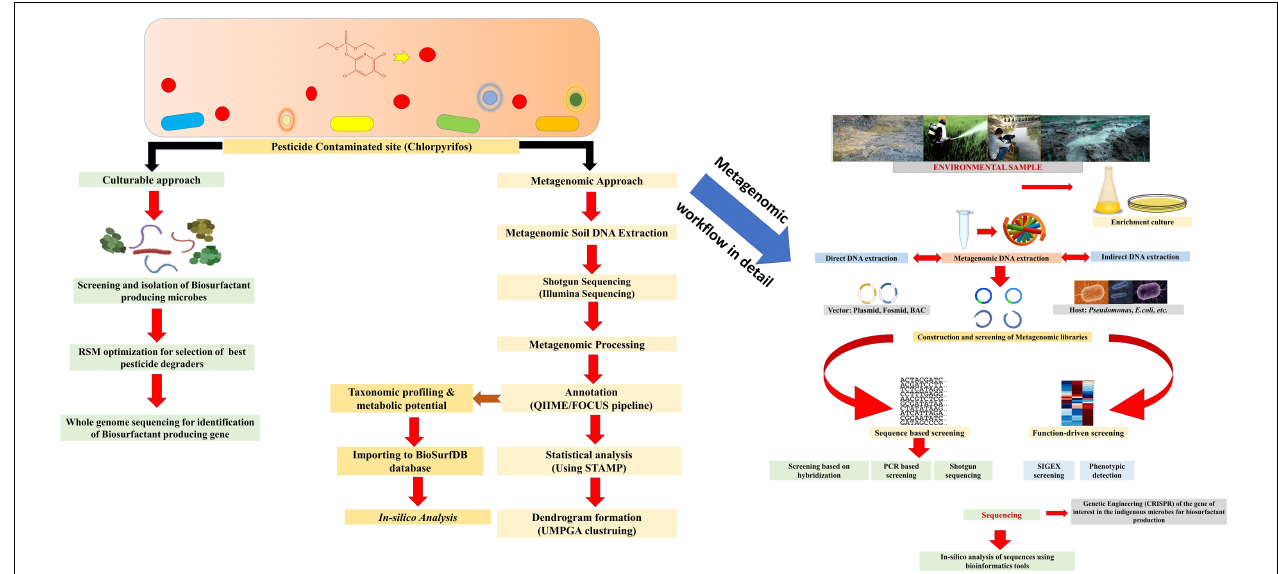
FIGURE 6 | Metagenomics workflow of biosurfactant producing